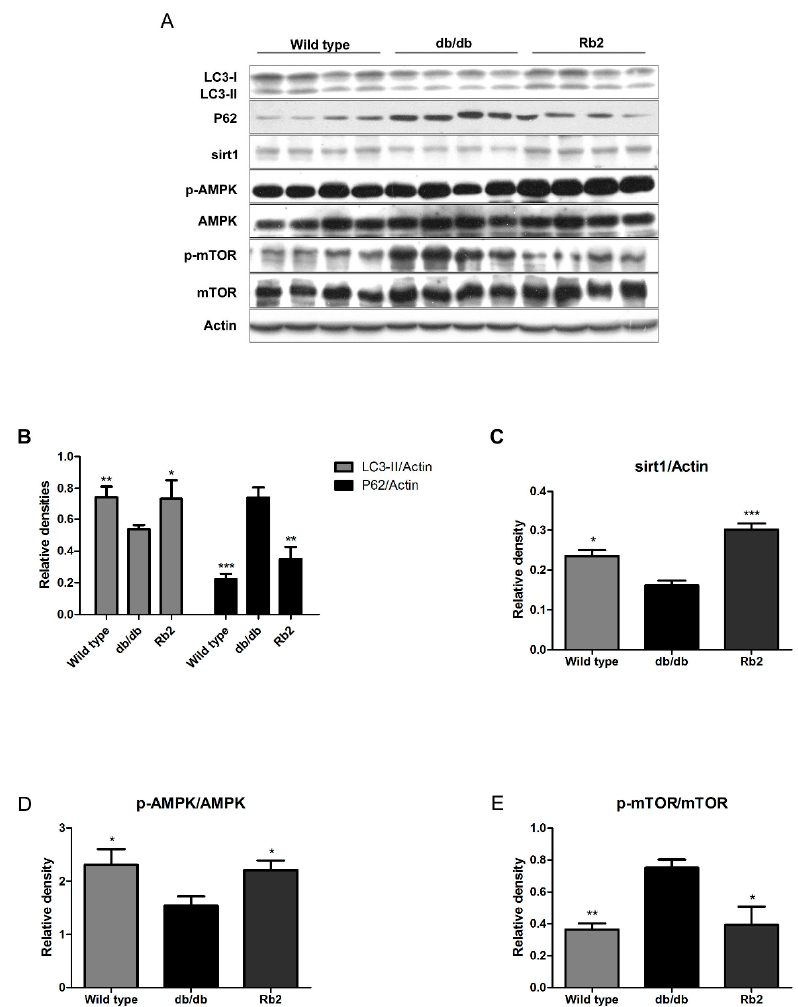
Figure 3. Effect of Rb2 on the hepatic autophagy pathway. Autophagy marker proteins from the liver were evaluated by Western blotting analysis ( A ). Bar chart showing the semi-quantitative integrated optical density (arbitrary units) of microtubule-associated protein 1 light chain 3II (LC3-II) and polyubiquitin-binding protein p62 (P62) normalized by actin ( B ), silent information regulator 1 (sirt1) normalized by actin ( C ), phosphorylated AMP-activated protein kinase (p-AMPK) normalized byAMPK ( D ), phosphorylated mammalian target of rapamycin (p-mTOR) normalized by mTOR ( E ). Wild type: Wild type mice as normal control, db/db: Vehicle-treated db/db mice, Rb2: Rb2 (10 mg/kg body weight)-treated db/db mice. Data are expressed as mean ± SE from three independent experiments. * p < 0.05, ** p < 0.01, and *** p < 0.001 compared with db/db group.